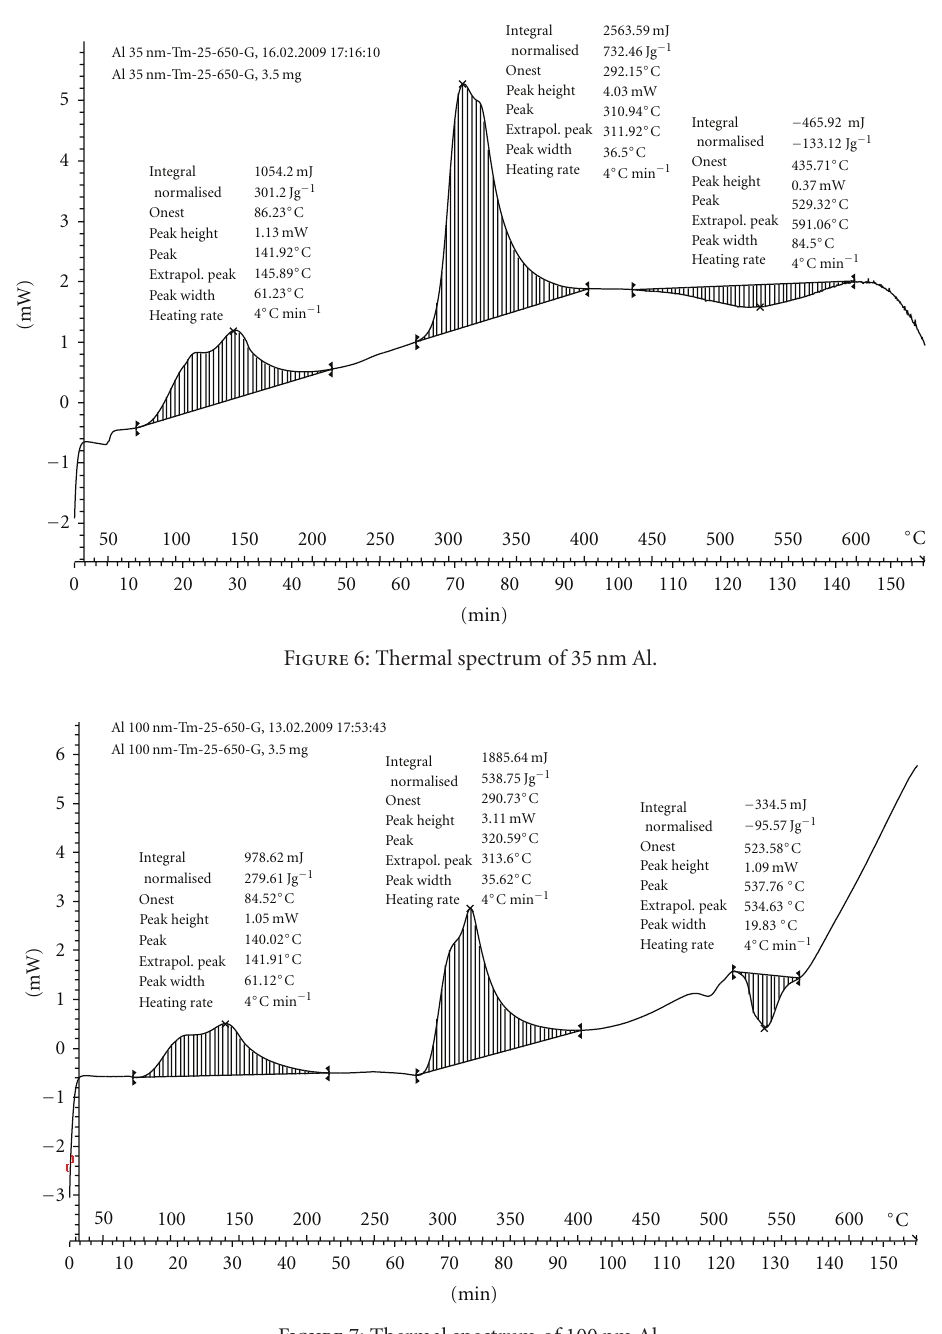
Figure 7: Thermal spectrum of 100 nm